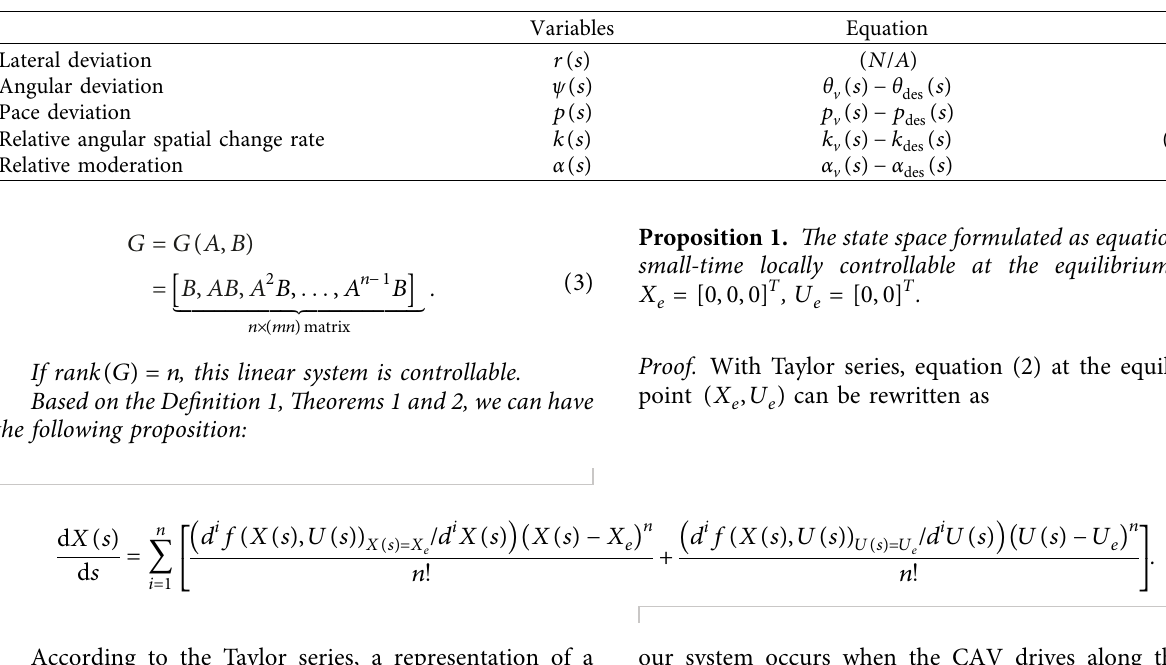
Table 1: Table of